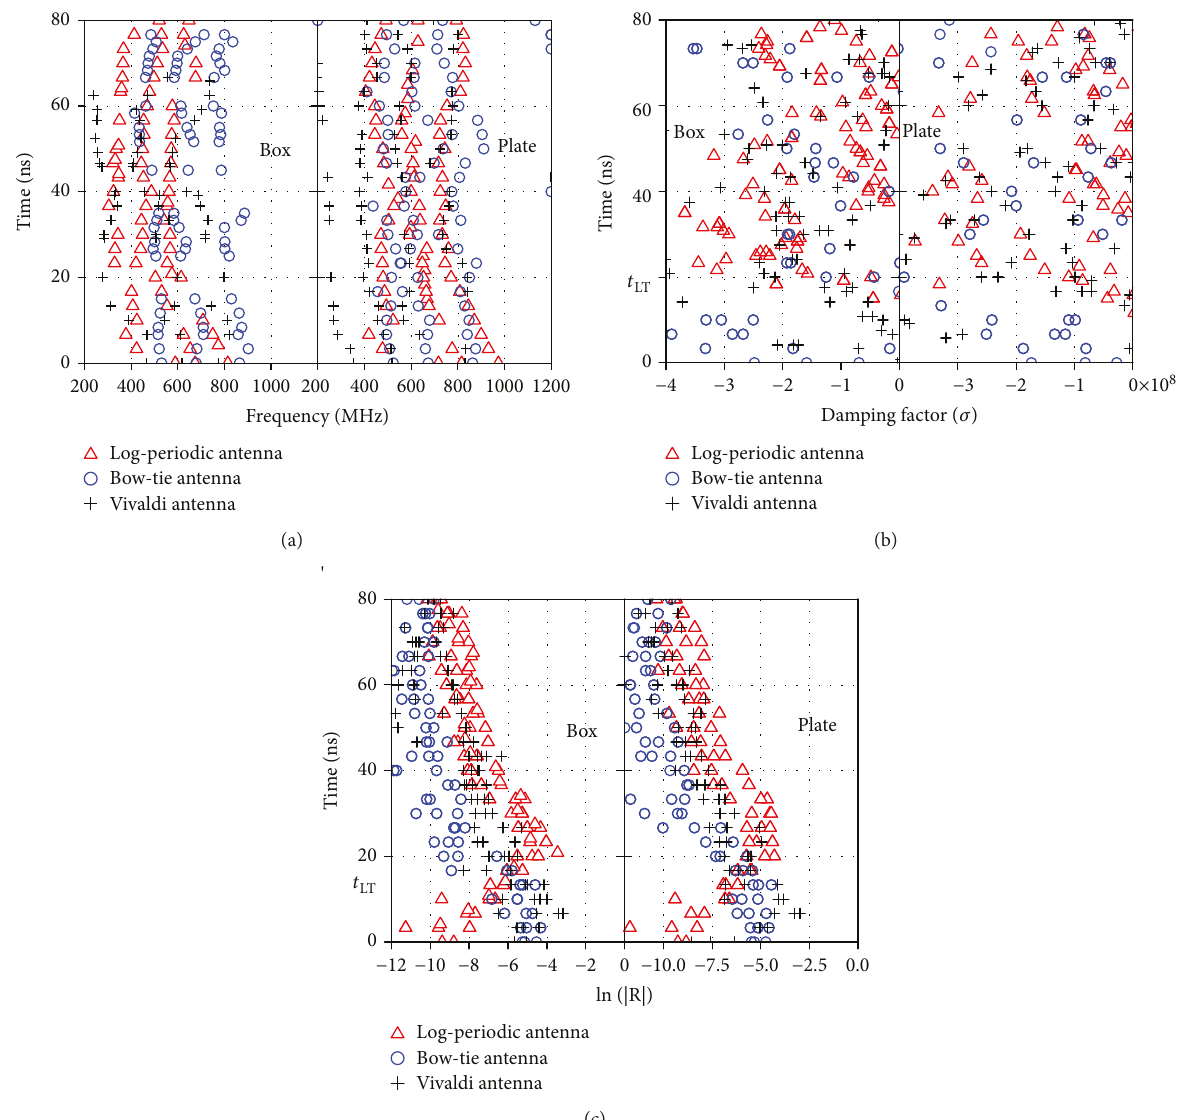
Figure 8: Extracted poles from experimentation without fi ltering the antenna e ff ects; (a) imaginary part (b) real part, and (c) magnitude of